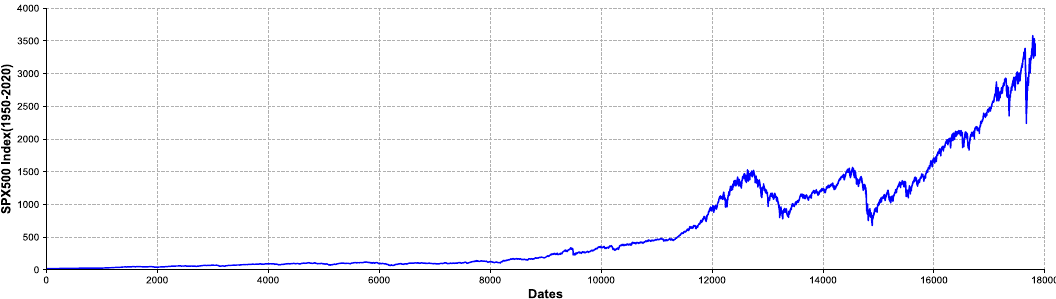
Figure 5. Trends in the SPX500 Index (1950-2020). 422